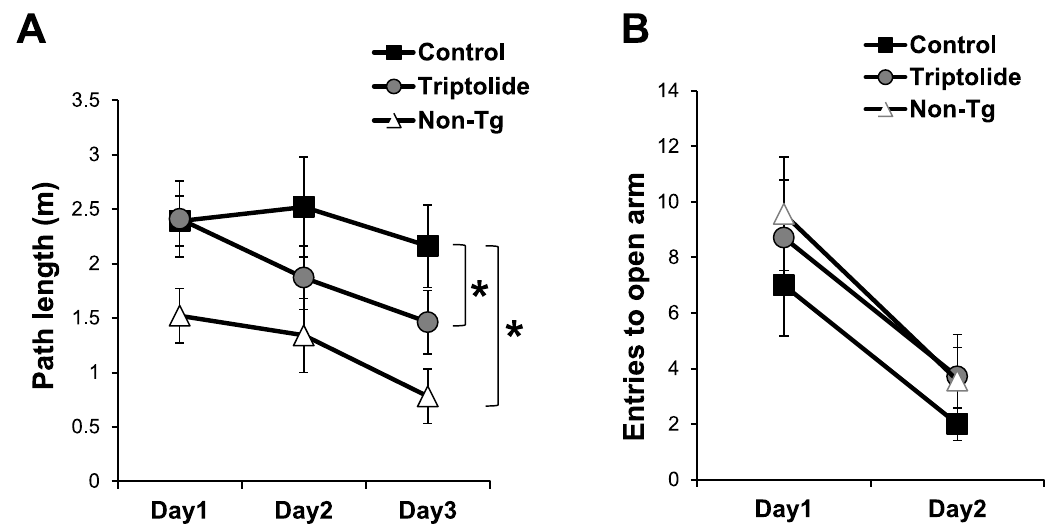
Figure 2. Triptolide treatment restores intersessional habituation in APP/PS1 mice. A , Untreated control APP/PS1 mice were more active than mice in any other groups and did not show intersessional habituation. Triptolide-treated APP/PS1 mice, in contrast, performed similarly as non- Tg mice and displayed intersessional habituation shown by decreasing activity in the latter 2 days of testing. B , Triptolide treatment had no effect on anxiety levels in the elevated plus maze tests. N=7 mice/group; Age=8 months; *, P , 0.05.